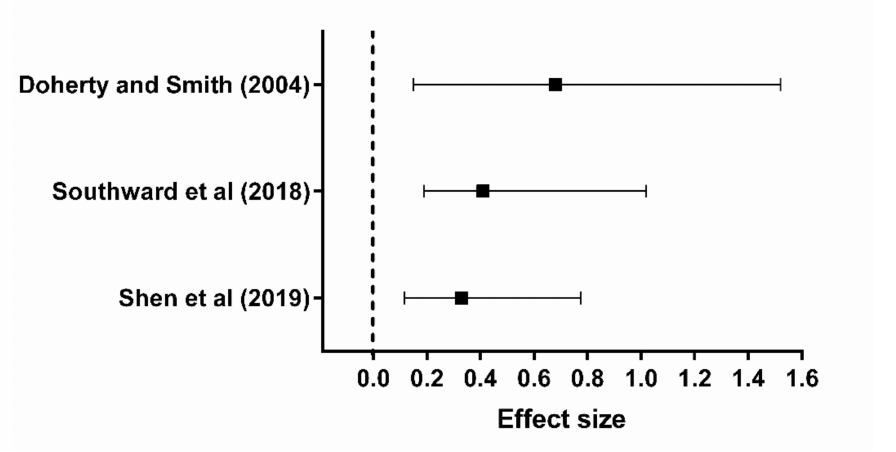
Figure 2. The ergogenic effect of caffeine ingestion on endurance performance measured using time trials (closed-loop exercises [9,11]), or time-to-task failure trials (open-loop exercises